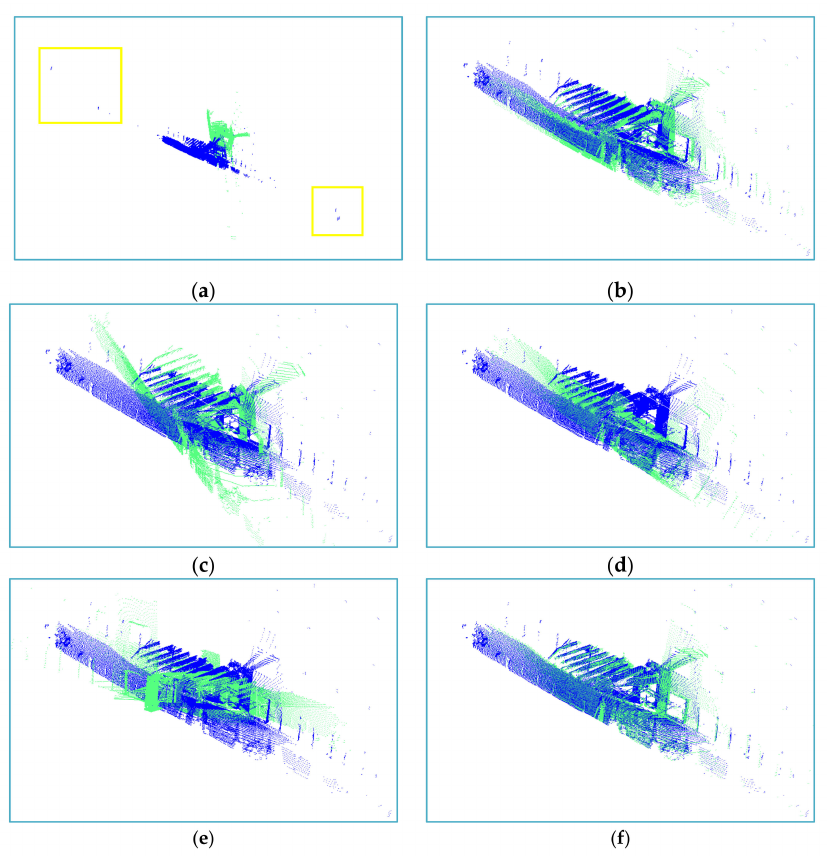
Figure 6. The registration results of each method in Dataset II (taking the registration of scan #25 to scan #24 as an example). ( a ) The original two scans; ( b ) Method I; ( c ) Method II; ( d ) Method III; ( e ) Method IV; ( f ) our method ( k = 512).